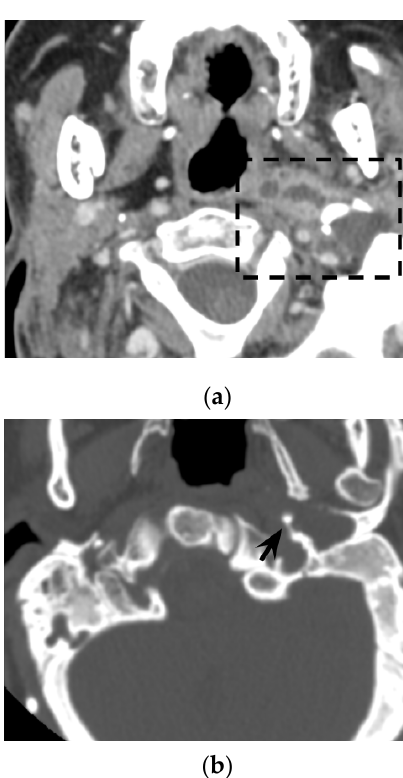
Figure 5. Thirty-year-old woman with oculo-auricular-vertebral spectrum. Contrast-enhanced axial CT ( a ) shows hypodense left neck abscess in the parapharyngeal and pharyngeal mucosal spaces, with minor involvement of the visceral and posterior cervical space (dotted rectangle). Note the peripheral enhancement and the soft tissue oedema. Axial CT with bone kernel ( b ) shows hypodense cholesteatoma eroding the os tympanicum (black arrow) as the origin of the neck abscess. Coronal T2w MRI ( c ) shows an hyperintense neck collection (white arrow) medial to the sternocleidomastoid muscle (white arrowhead). The patient proved to have a Bezold’s abscess associated with an os tympanicum cholesteatoma.